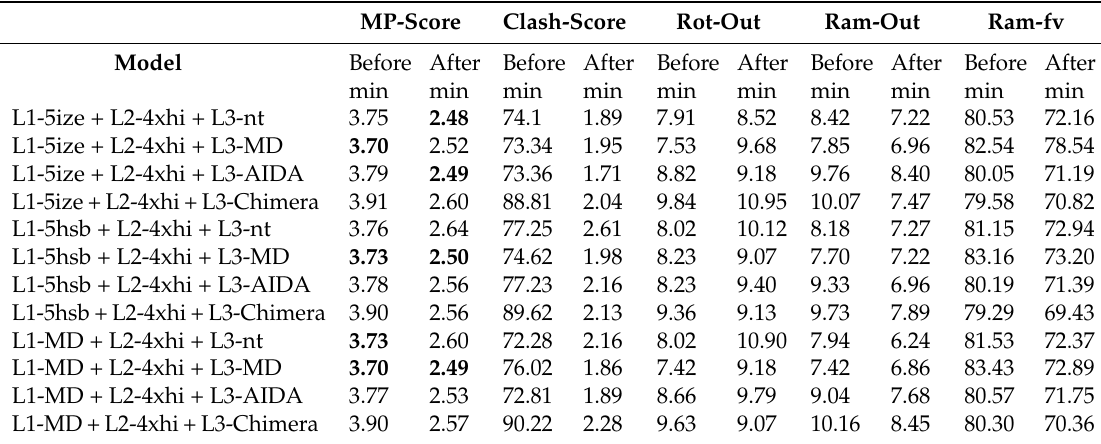
Table 3. Molprobity evaluation of full-length L protein structures refined with 3DRefine, before and after structural relaxation. The best MP-scores are given in